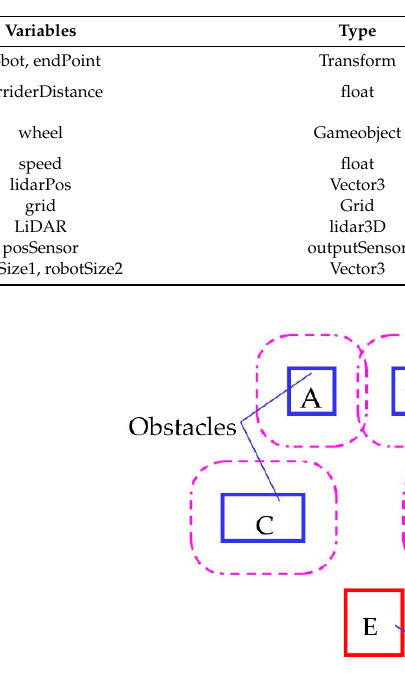
Table 9. Definition of data members and related variables in the “Navigation” program.